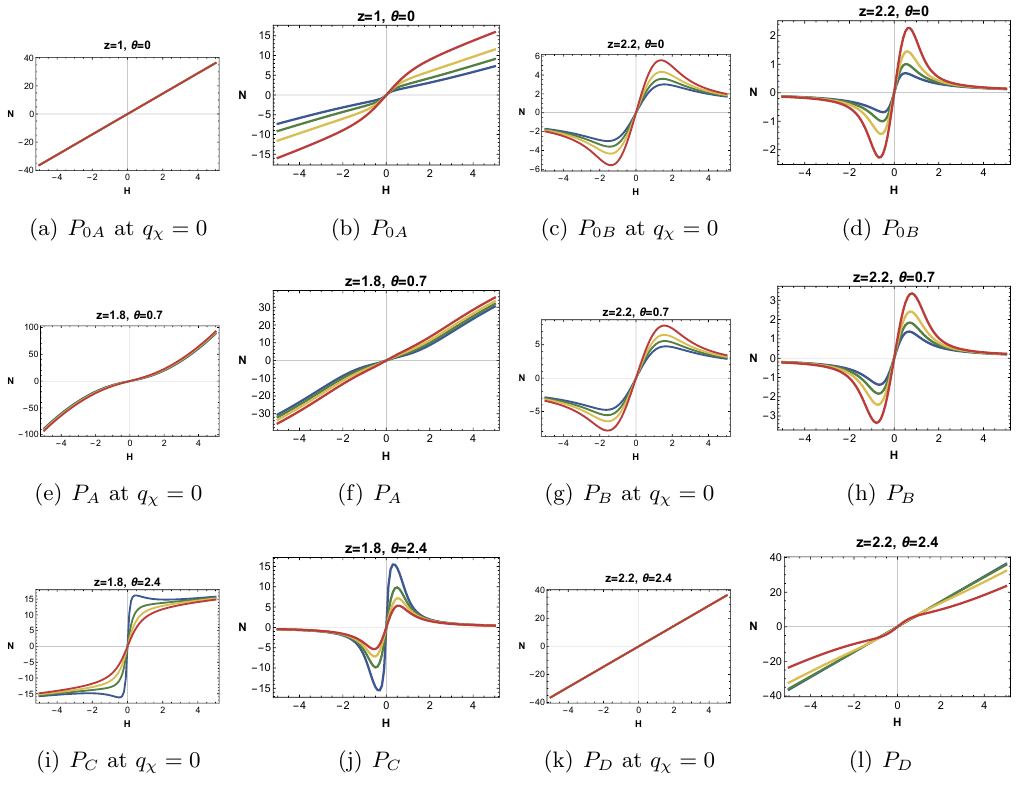
Figure 15 . Temperature evolution for N ( H ) for for each region of ( z; (cid:18) ). Curves corresponds to T = 0 : 04 ; 0 : 1 ; 0 : 16 ; 0 : 24 for blue, green, yellow, and red respectively. We used q (cid:31) = 0 : 7 for all non-zero q (cid:31)